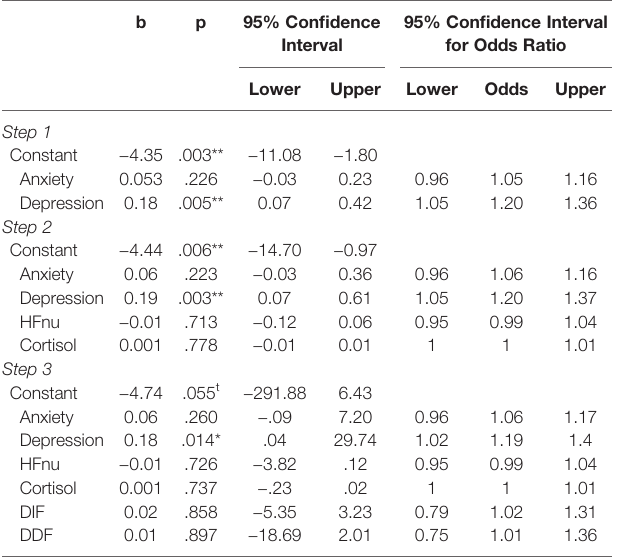
TABLE 5 | Summary of hierarchical logistical regression analysis predicting the presence of irritable bowel syndrome (IBS) (95% BCa bootstrap con fi dence intervals based on 5,000 samples).